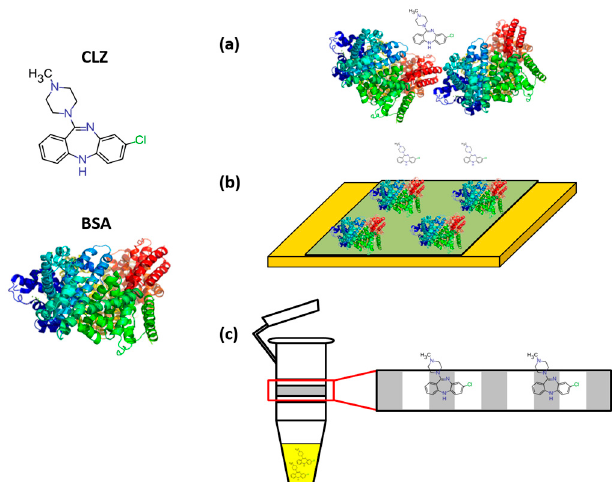
Figure 3. Schematics illustrating potential signal loss due to ( a ) screening, ( b ) electrode fouling and ( c ) non-specific membrane binding (NSMB). In ( a ), electrostatic interactions due to BSA crowding are preventing the CLZ from reaching the electrode entirely, whereas in ( b ), BSA aggregates directly onto the electrode surface, diminishing the exposed surface area for the CLZ to react with the electrode. On the left of ( c ), the CLZ is represented in the filtrate sample to be measured electrochemically, whereas the right side of the image depicts CLZ that has become trapped in the membrane during ultrafiltration.